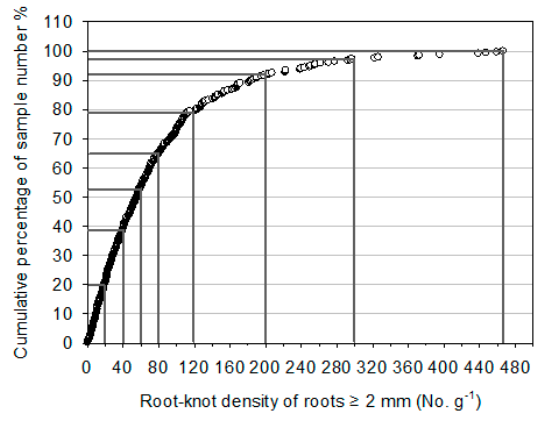
Figure 5. Progressive gradient of root-knot density of roots with a root diameter ≥ 2 mm divided into